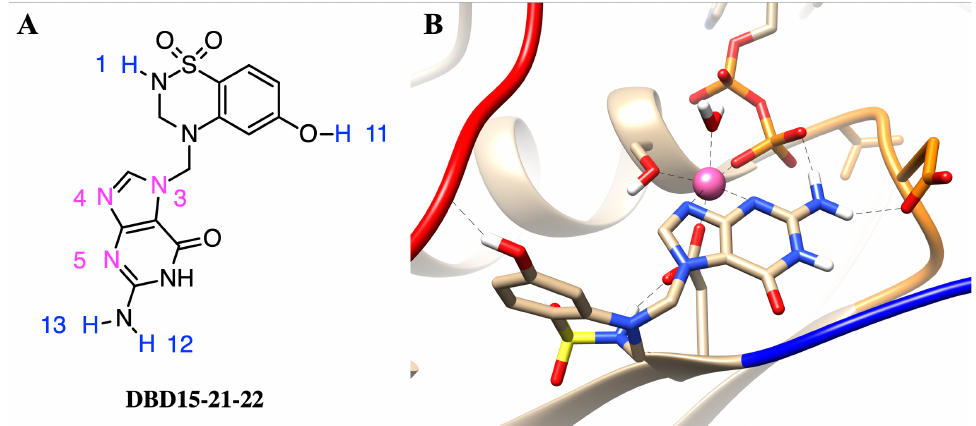
Figure 4. ( A ) Chemical structure of designed inhibitor DBD15-21-22 and ( B ) sketch of the interaction of details DBD15-21-22 with KRAS-G12D. Colors as in Figure